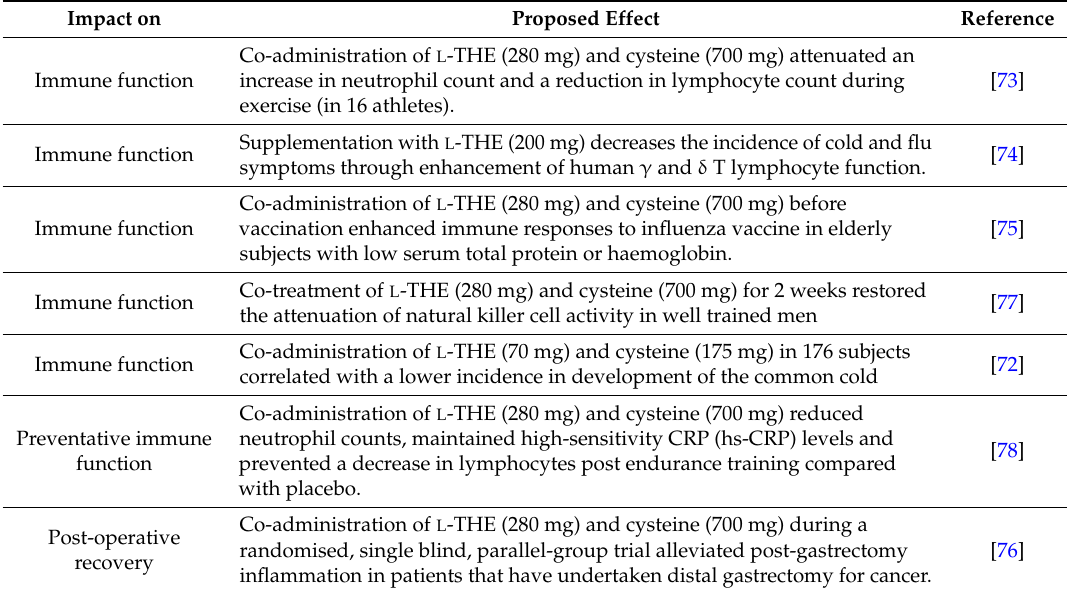
Table 3. The effect of L -THE consumption on immune function.